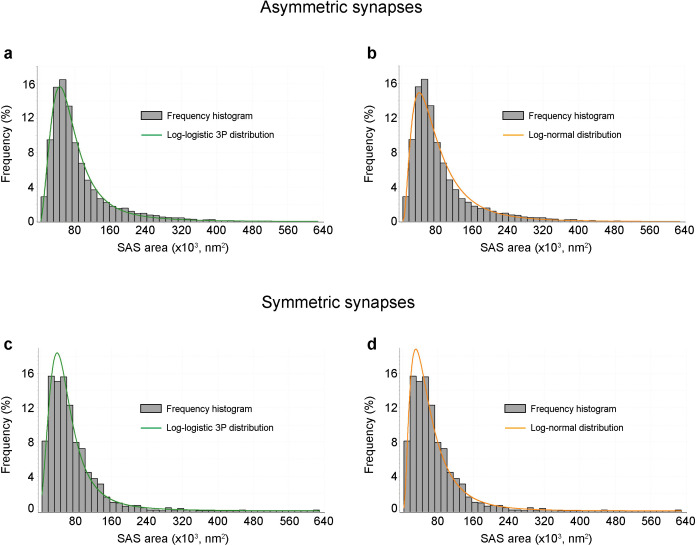
Frequency histograms of synaptic apposition surface (SAS) areas and their corresponding best-fit probability density functions.(a,b) AS from all layers have been pooled together to build the frequency histograms (blue bars). (c,d) SS from all layers have been pooled together to build the frequency histograms (blue bars). The best-fit distributions representing the theoretical probability density functions have been represented with their corresponding frequency histograms: the log-logistic 3P (green trace) in (a, c) and the log-normal (orange trace) distribution in (b, d). Note the similarity between the log-logistic 3P and the log-normal distribution. The parameters α, β and γ of the log-logistic 3P curves and the parameters σ and μ of the log-normal curves are shown in Supplementary file 1L.